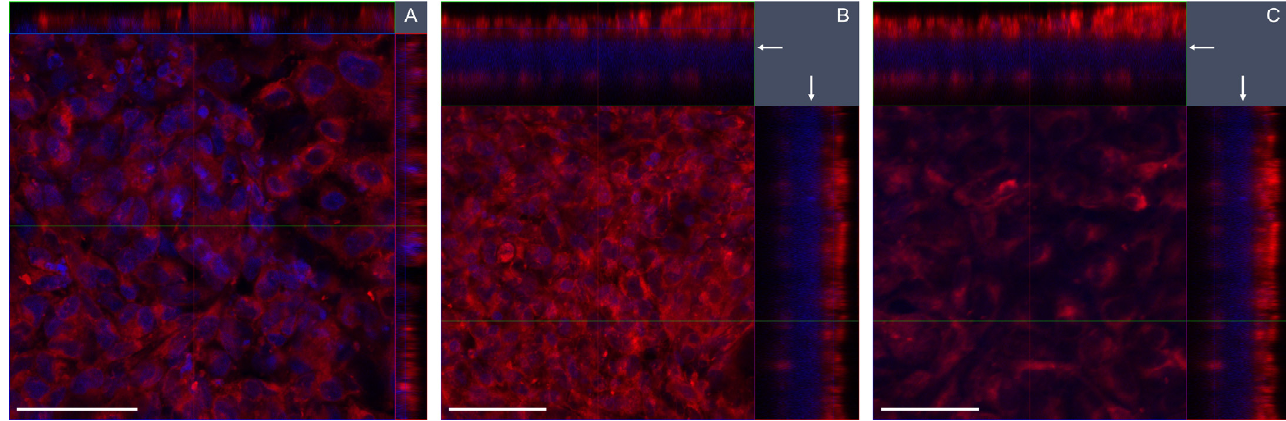
Figure 2. Confocal images of advanced bronchial BEAS-2B models. Z-stack image series (2D x–y view and respective side views) showing the distribution of BEAS-2B and EA.hy926 cells on the opposite sides of a transwell membrane insert (arrow). ( A ) BEAS-2B cells in monocultures (z-stack thickness 12 µm). ( B ) BEAS-2B cells in cocultures (z-stack thickness 52 µm). ( C ) EA.hy 926 cells in cocultures (z-stack thickness 52 µm). Red: cellular membranes stained with Cell Mask red dye; blue: nuclei counterstained with DAPI. Magnification: 40×. Scale bars 50 µm. Table 2. Number of live cells, cell density and cell viability from ALI cultures at the end of the cultivation period, evaluated by cell counting with trypan blue staining after detaching the cells from the inserts. Results are presented as mean with standard deviation (SD) from 2–3 independent experiments ( n ) and 2–7 replica culture inserts in each experiment. ALI: air–liquid interface.